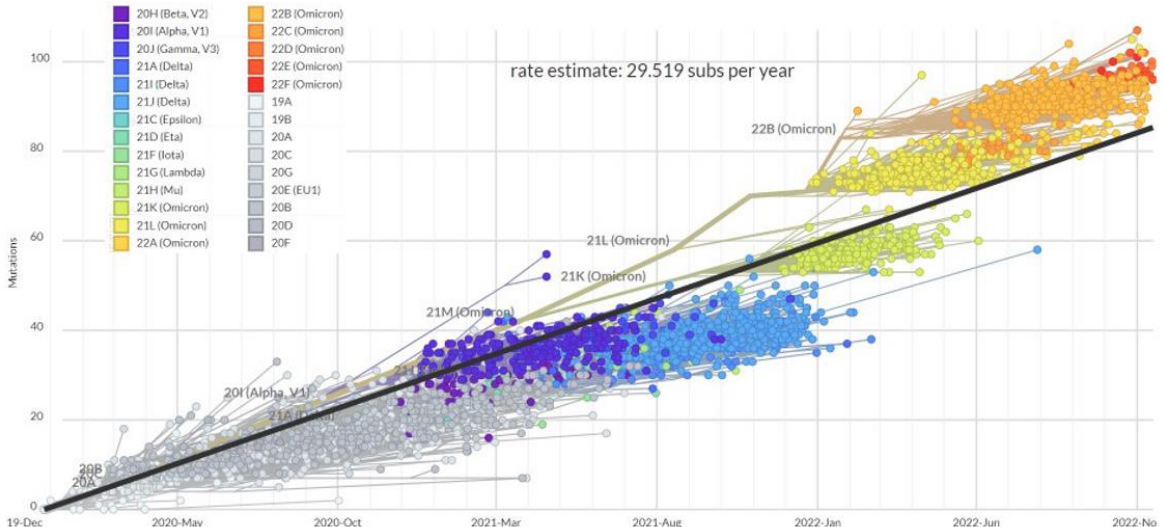
Figure 2. Clock tree of SARS-CoV-2 evolution, with regression line showing an increase in the estimate rate of substitutions per year across 3045 genomes sampled between December 2019 and November 2022. Accessed online at https://nextstrain.org/ncov/gisaid/global/all-time?l=clock&m=div (accessed on 26 November 2022).